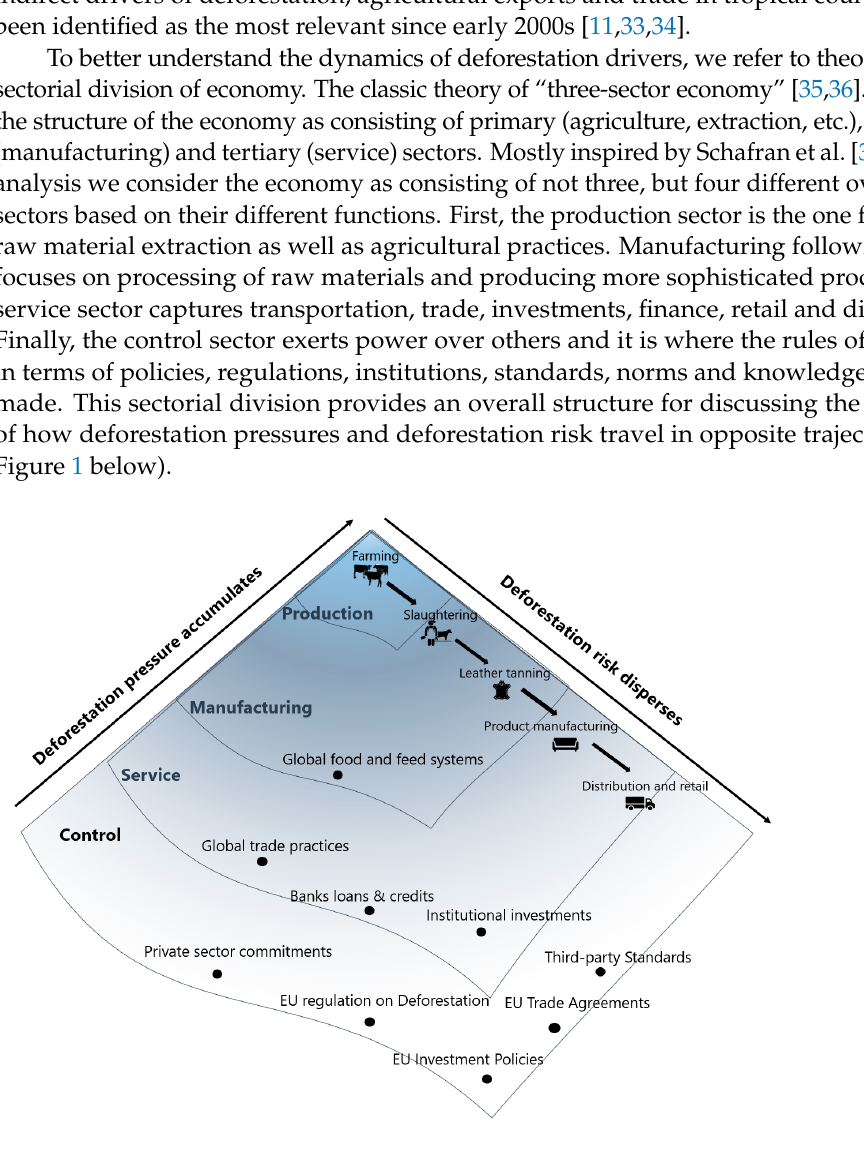
Figure 1. Leather supply chain situated within the economic system model and the opposite trajec- tories of the dispersal of deforestation risk and accumulation of pressure for deforestation.